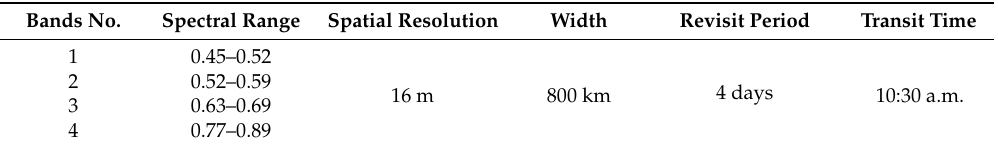
Table 1. Specifications of GF-1 WFV